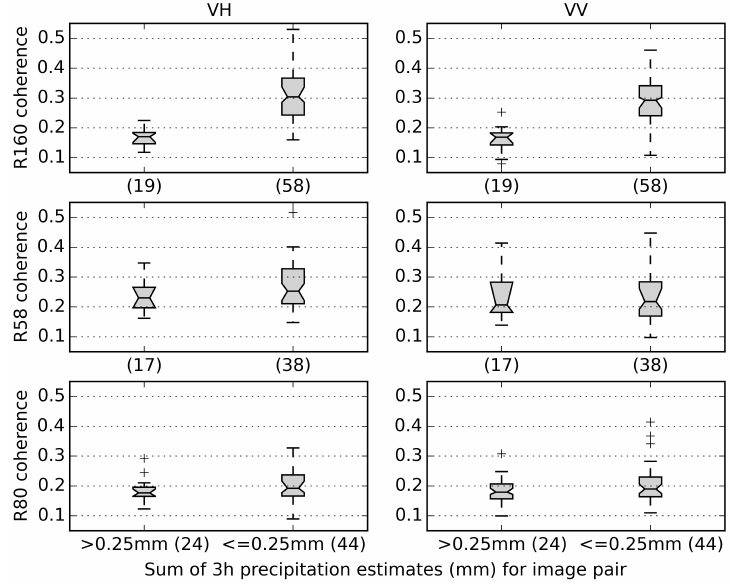
Figure 6. Box plots comparing coherence values for two groups—where the sum of 3-h precipitation estimates was >0.25 and ≤ 0.25 mm. Group sizes are given in parenthesis. Coherence values and the sum of precipitation estimates are calculated for first image pair within 12 days after a mowing event. The box extends to first (Q1) and third (Q3) quartile values, the whiskers extend to 1.5 times interquartile range (IQR = Q3 − Q1) from the box (e.g., Q1 − 1.5 × IQR), beyond the whiskers, data points are considered outliers. The notches around the median represent 95% confidence intervals calculated with 5000 bootstrap